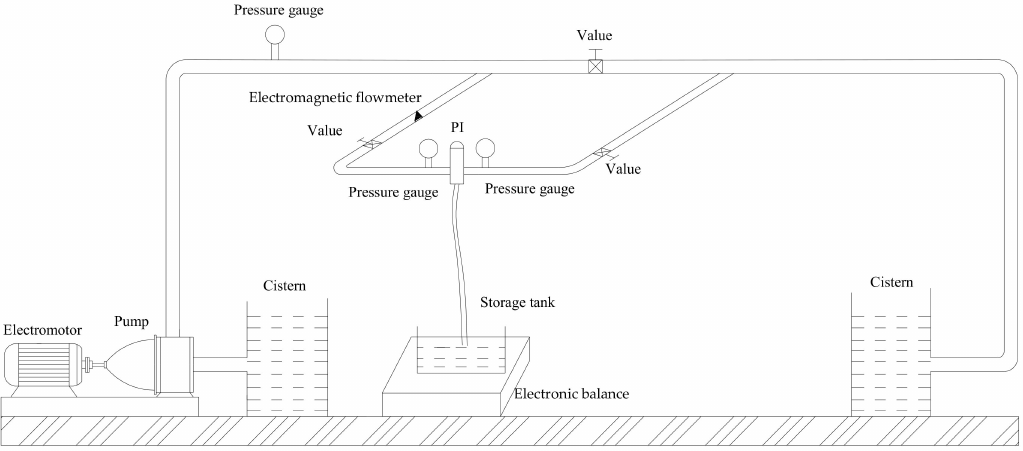
Figure 2. Structural diagram of experimental